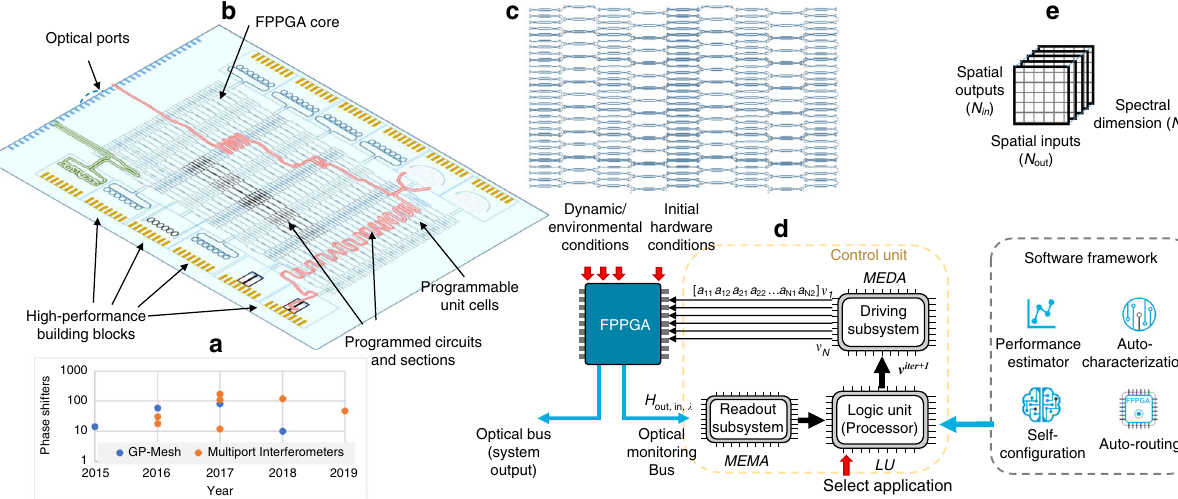
Fig. 1 Photonic Integrated hardware and control architecture of multipurpose programmable photonic circuits. a Number of integrated phase shifters in recent waveguide mesh circuits (see Supplementary Note 11), b labeled fi eld programmable photonic gate array (FPPGA) architecture, including a waveguide mesh core and high-performance building blocks, c FPPGA core employing a longitudinally parallel hexagonal waveguide mesh interconnection topology 22 , d electronic control subsystem, signals and software procedures to control the programmable photonic integrated circuit, e data array of the full scattering matrix of the FPPGA core, including input and output spatial ports and the optical spectral dimension. GP general-purpose, MEMA multichannel electrical monitoring array, MEDA multichannel electrical driving array, LU logic